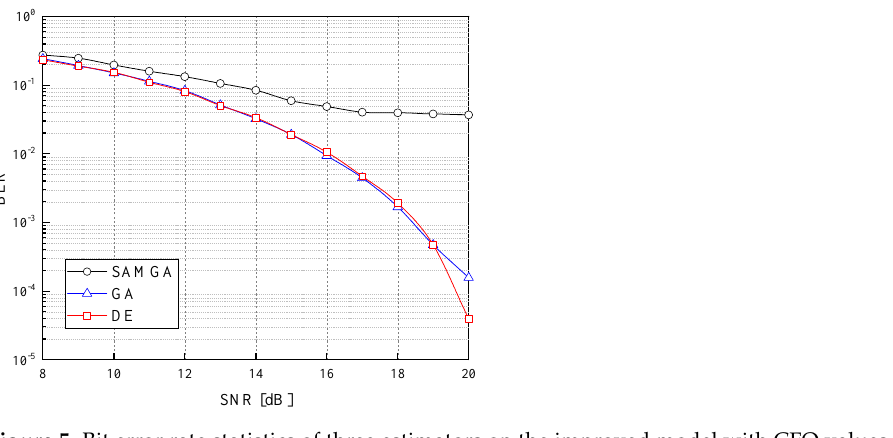
Figure 5. Bit error rate statistics of three estimators on the improved model with CFO values varying as a sinusoidal function.